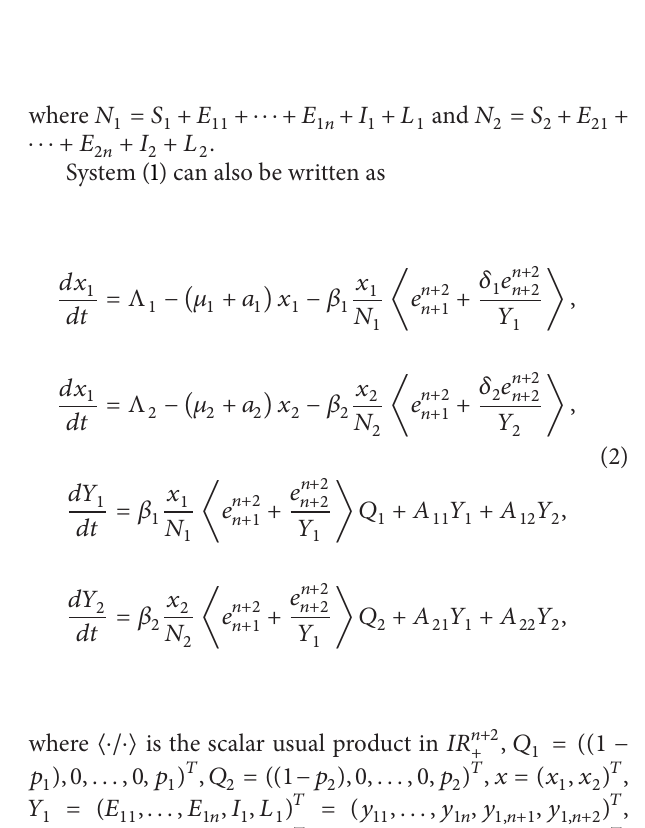
Figure 1: Flow chart of a two-patch model of tuberculosis with lost sight individuals in sub-Saharan Africa, with migrations at rate 𝑎 𝑖 between susceptible individuals of two populations, at rate 𝑏 𝑖𝑗 between latently infected individuals of two populations, at rate 𝑐 𝑖 between infectious individuals in care centre, and at rate 𝑓 𝑖 for infectious lost sight individuals. An individual of a given population (patch) has contacts only with individuals of the same